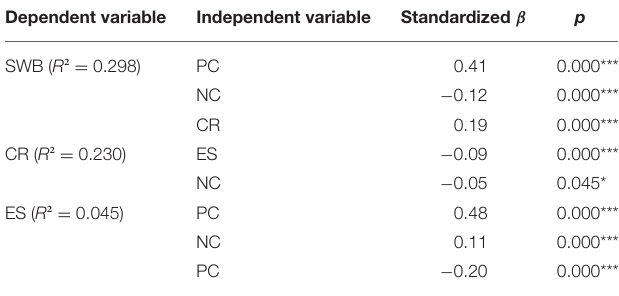
TABLE 3 | Parameter description of variables in regression analysis.